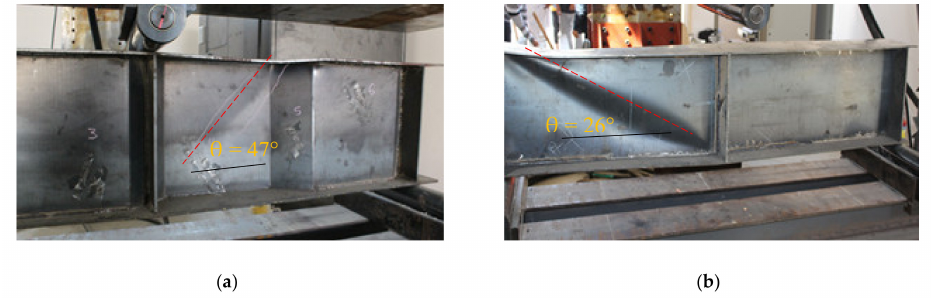
Figure 10. Failure modes: ( a ) Specimen CW35IFNW; ( b ) Specimen